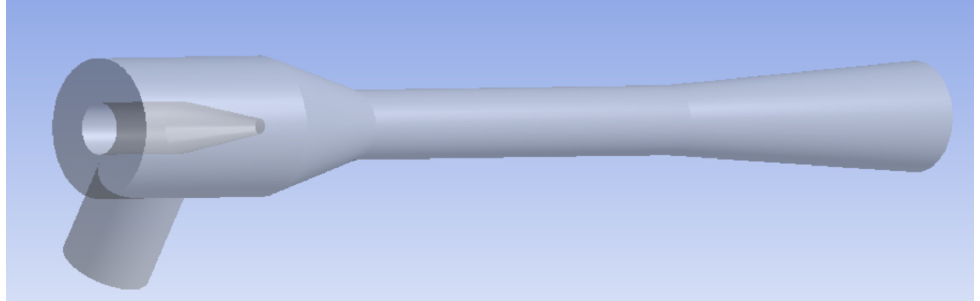
Figure 3. Experimental system diagram of the mixer-ejector operating characteristics.